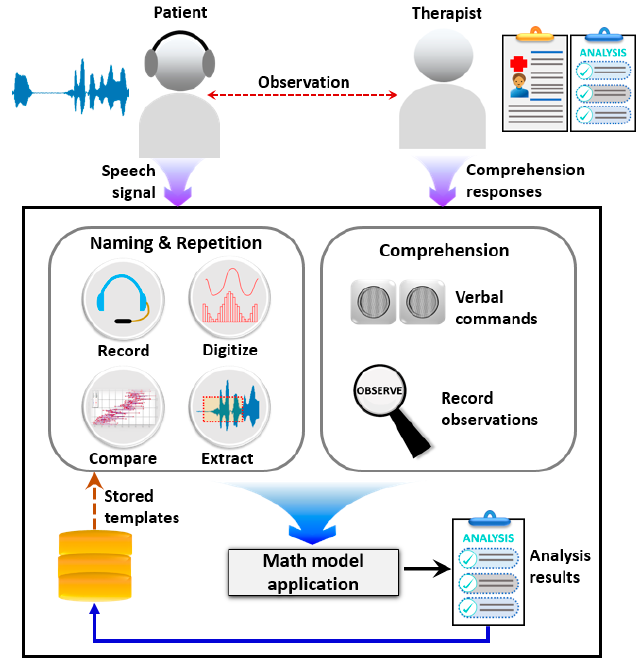
Figure 2. Pictorial overview of the proposed semi-automated aphasia diagnosis system.